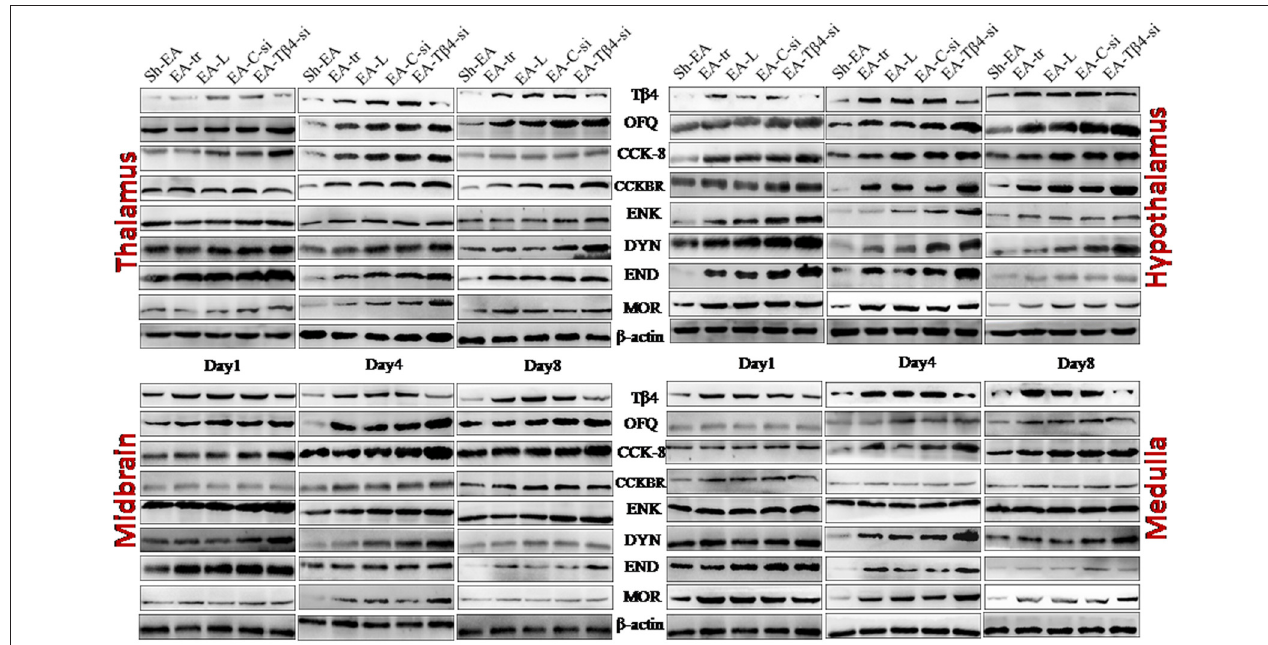
FIGURE 5 | The represented bands of T β 4, OFQ, CCK-8, CCKBR, ENK, END, DYN, and MOR detected with western blotting in the thalamus, hypothalamus, midbrain and medulla of rats on day 1, 4, and 8.